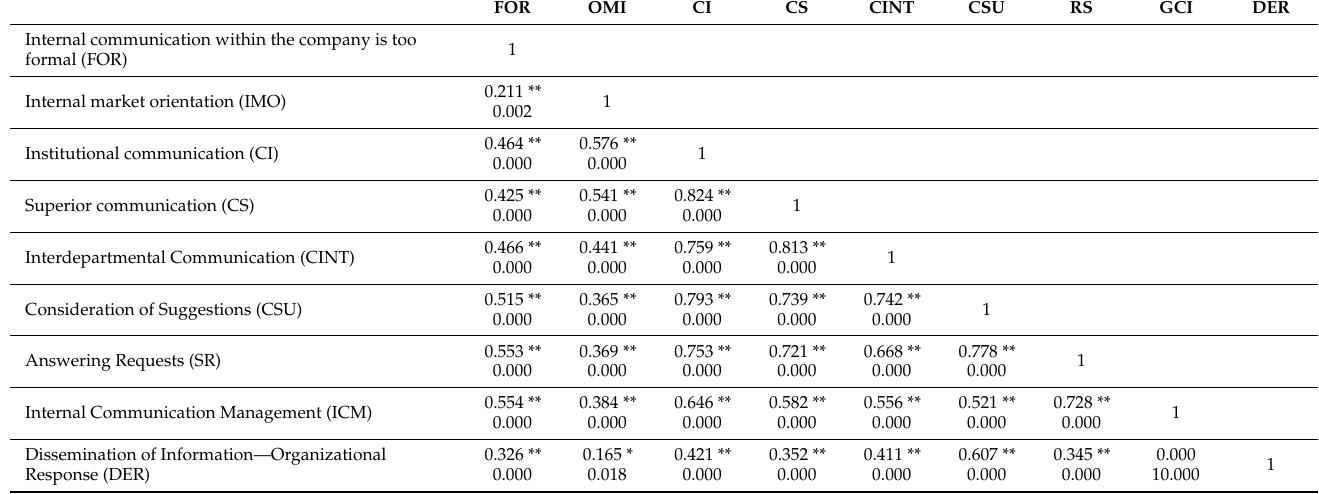
Table 15. Correlations between